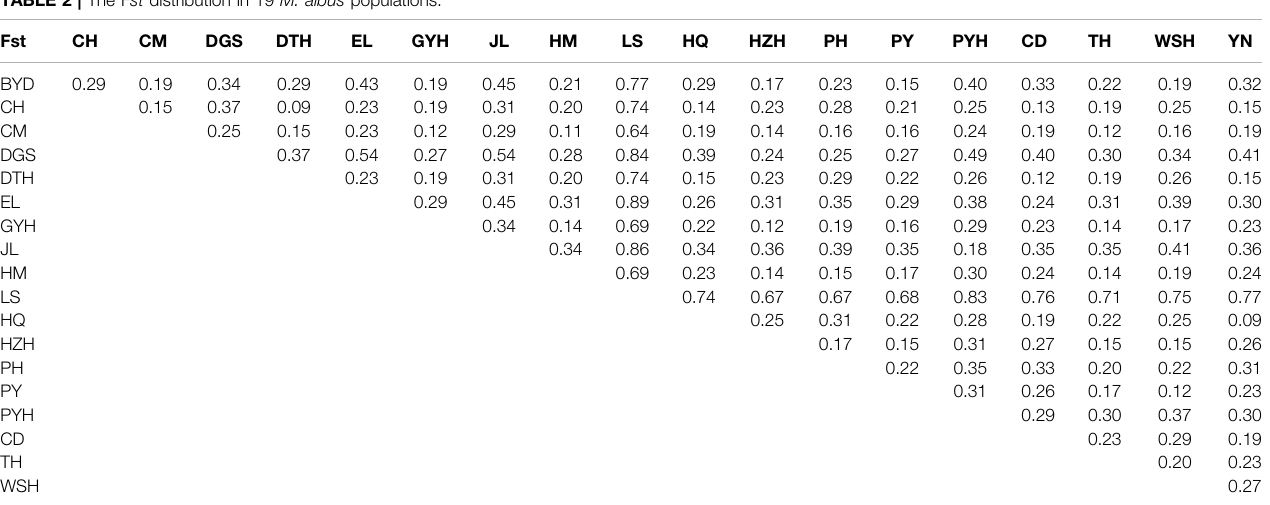
Fstvaluesbetween0.15and0.25representasigni fi cant difference,Fstvalues > 0.25representanextremelysigni fi cantdifference,Fst=0 – 0.05indicateslowgeneticdifferentiation,and Fst = 0.05 – 0.15 indicates moderate genetic differentiation among populations. The abbreviations represent the sampling sites: BYD, Baiyangdian Lake; CD, Chengdu City; CH,